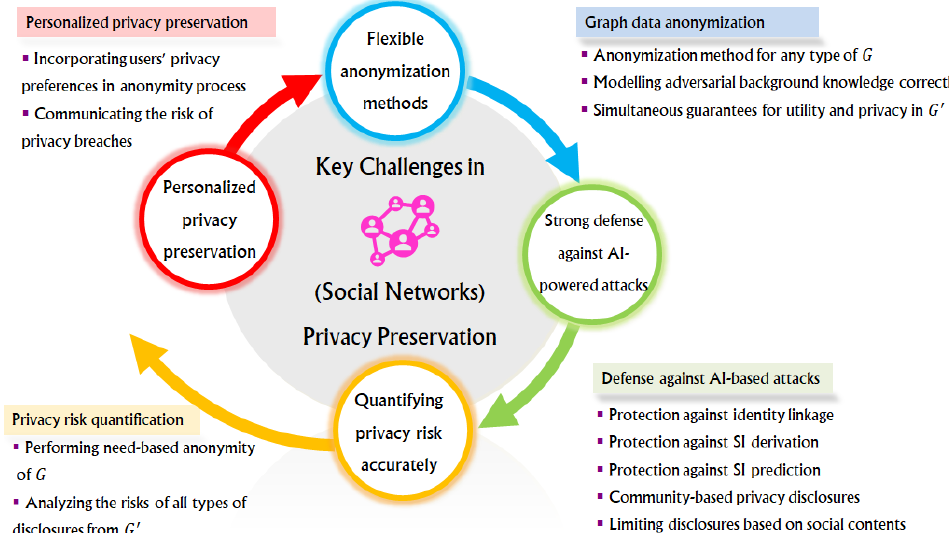
Figure 25. High-level overview of challenges in OSN privacy